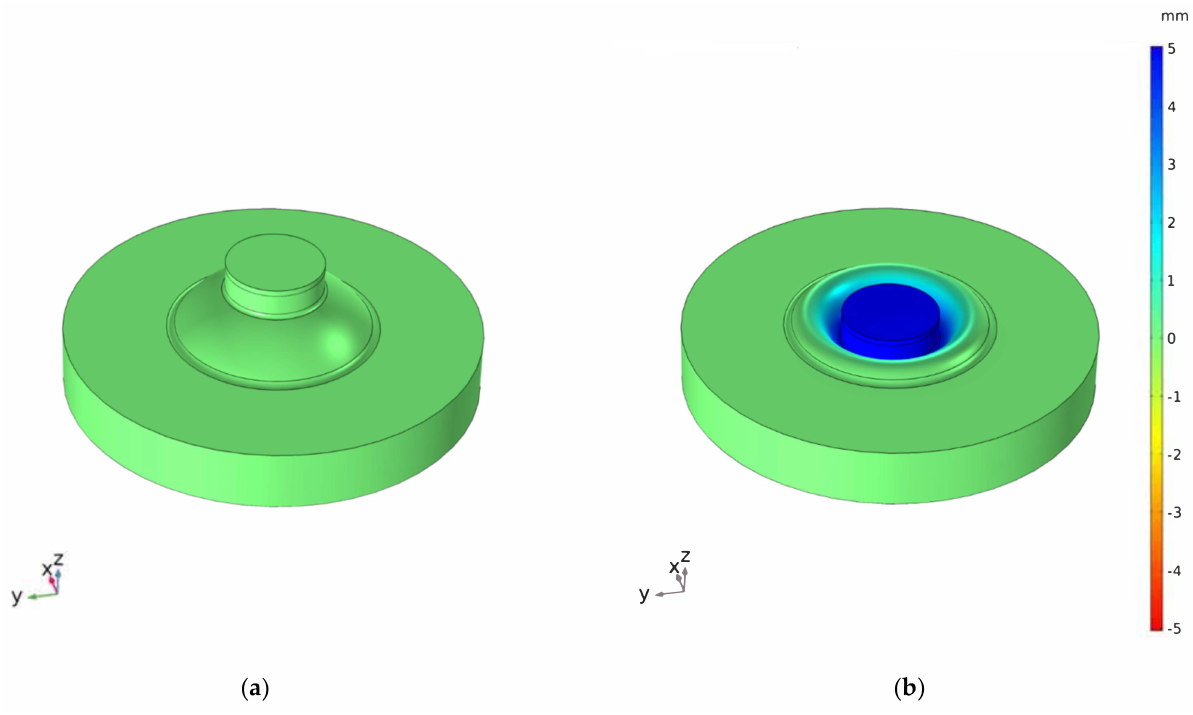
Figure 9. Three-dimensional (3D) FE of the dome, obtained from a rotation of the 2D model in Figure 8 along the z axis: ( a ) Undeformed configuration; ( b ) Deformed